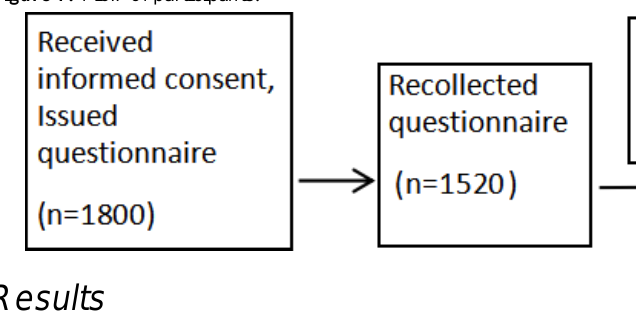
Figure 1. Flow of